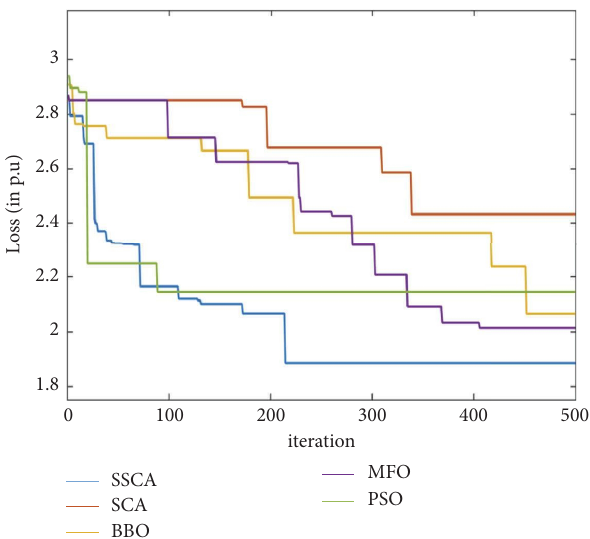
Figure 12: Loss variation in the IEEE-118 bus system at 125% loading.